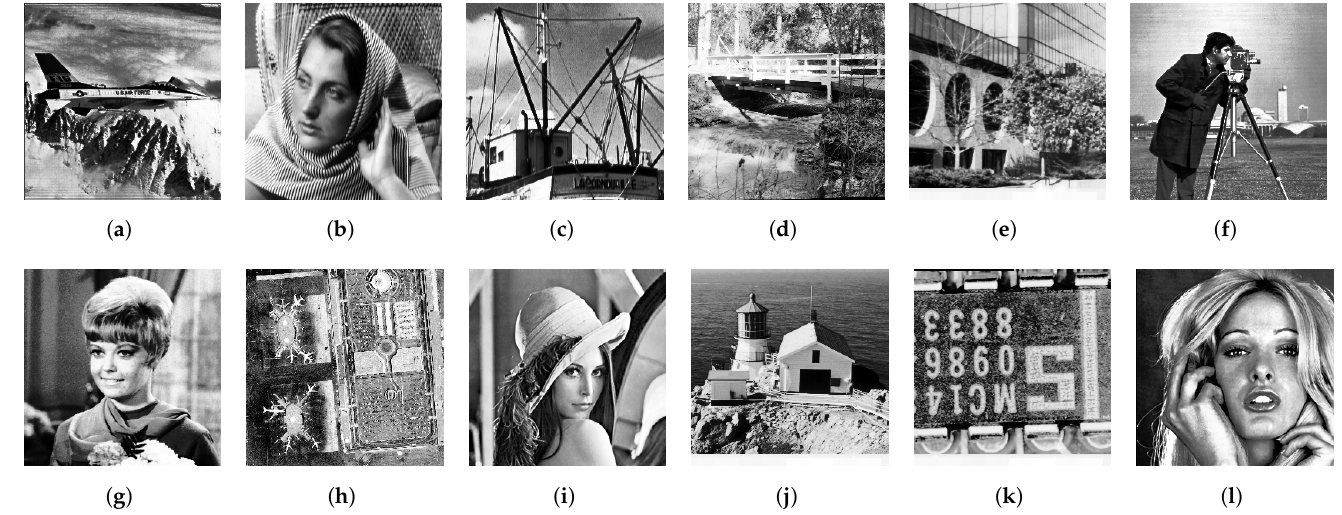
Figure 14. Nikolova and Steidl’s exact histogram equalization: ( a ) Airplane, ( b ) Barbara, ( c ) Boat, ( d ) Bridge, ( e ) Building, ( f ) Cameraman, ( g ) Girl, ( h ) Lax, ( i ) Lenna, ( j ) Lighthouse, ( k ) Text, ( l ) Woman.